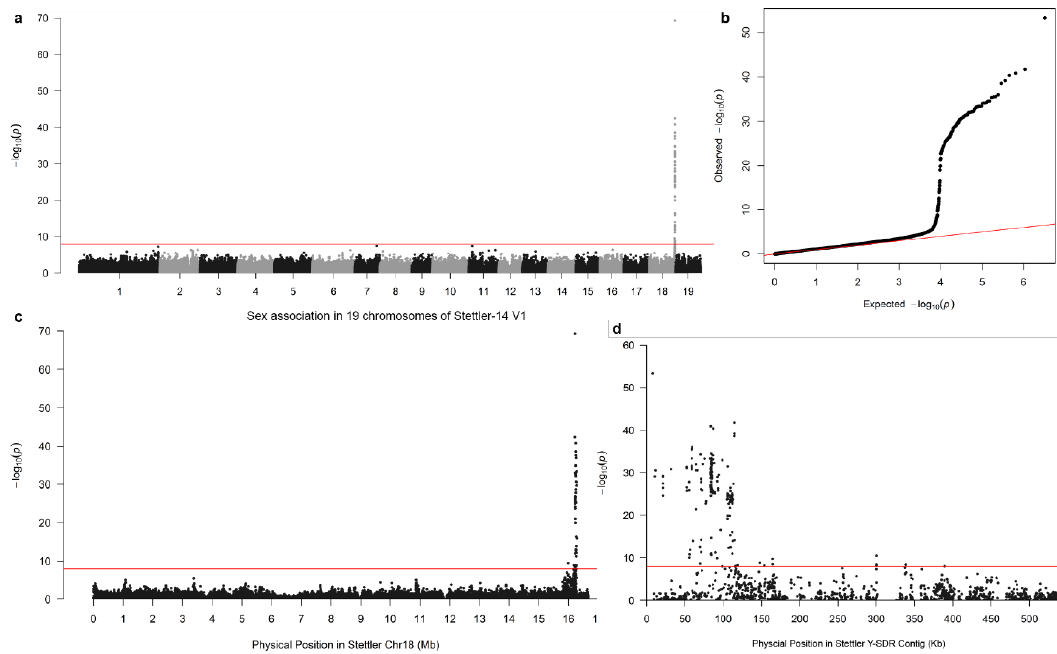
Figure 1. Sex association analysis with markers from the V1 main genome of Stettler-14. ( a ) Manhattan plot of p -values from sex-association analysis with 200 individuals in 19 chromosomes. ( b ) A quantile- quantile plot of the p -values the association analysis was displayed. For display, markers with no sex association were thinned to a minimum 100 bp spacing. ( c ) A close look at the sex-associated markers on chromosome 18. The red line indicates the Bonferroni cutoff (1.09 × 10 − 8 ) in ( a ) and ( c ). ( d ). A further zoom-in at the sex-associated markers on the Y-SDR contig. For convenience, plotted markers are a subset of the original dataset.